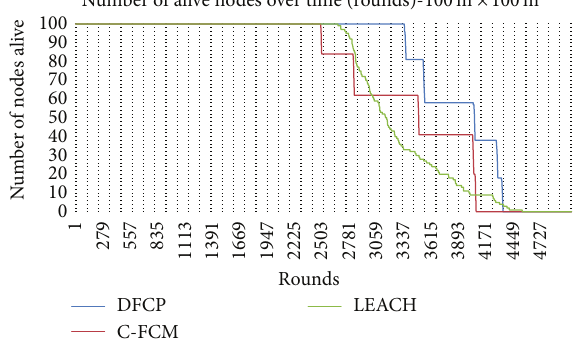
Figure 5: Network lifetime for 100m × 100 m WSN.